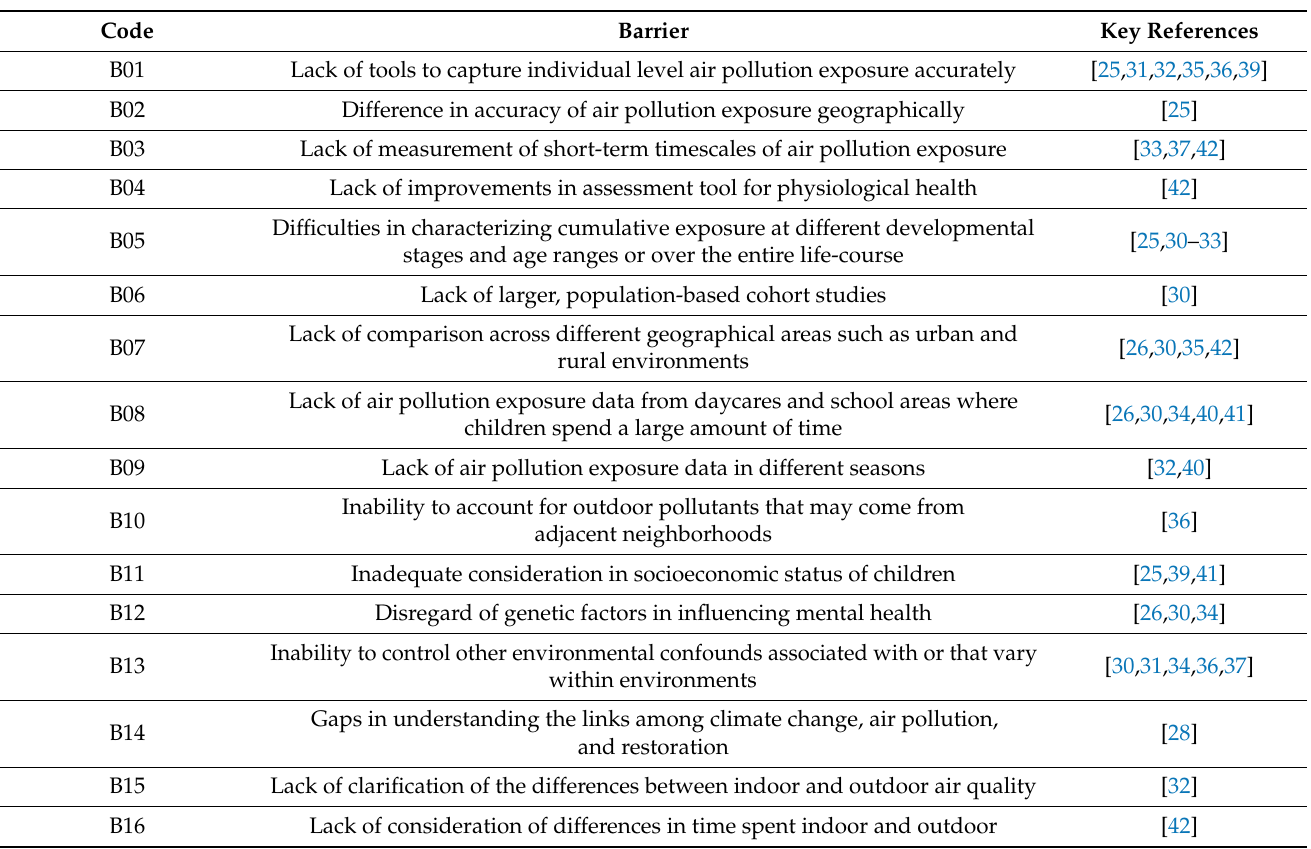
Table 5. Barriers Obtained from the Literature Review.